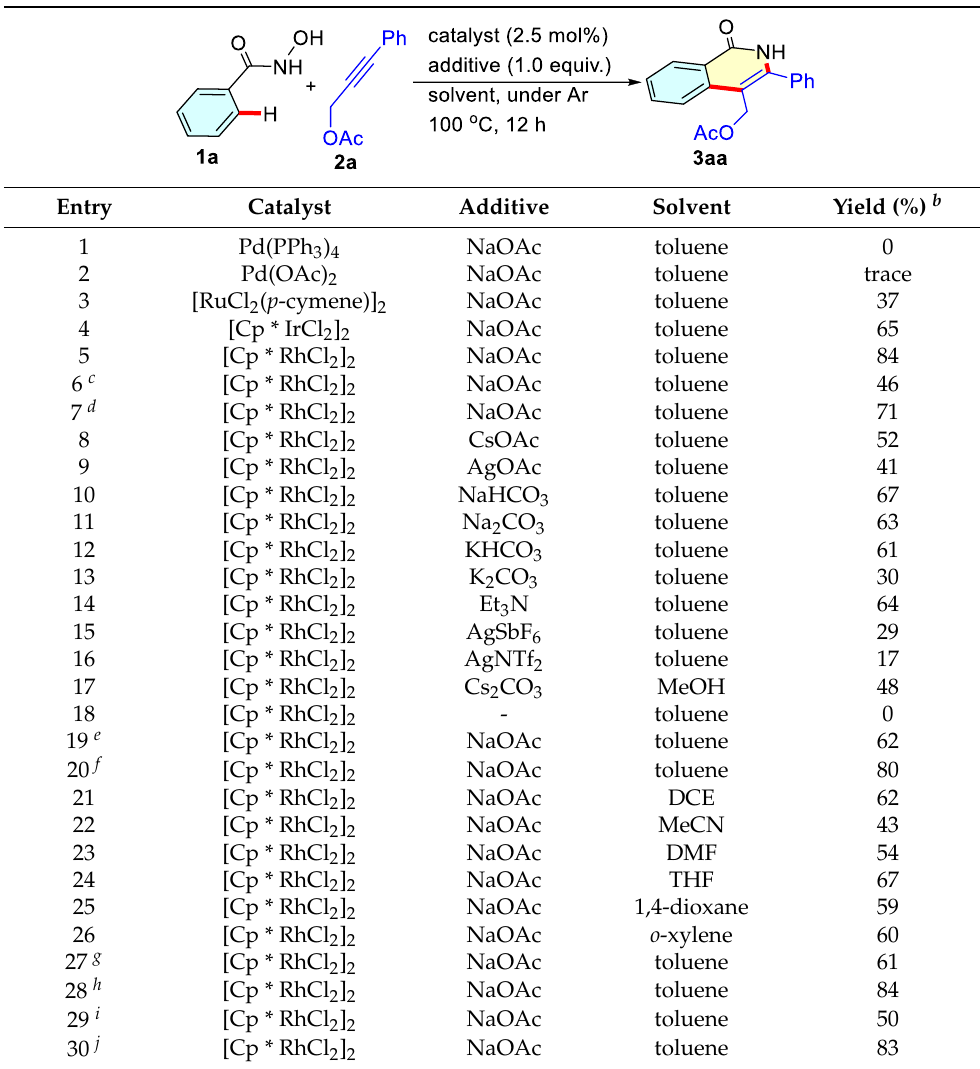
Table 1. Optimization of the reaction conditions a .